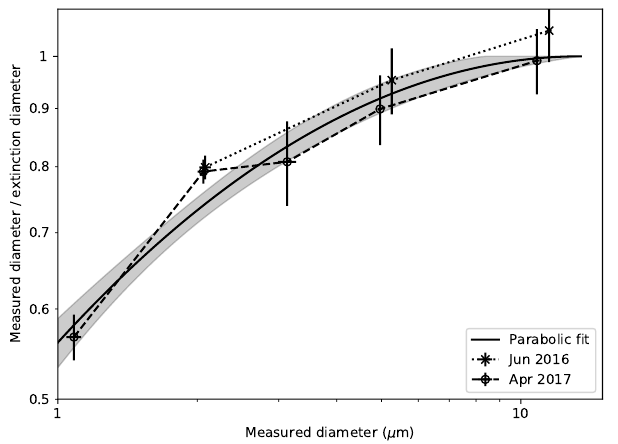
Figure 5. Size distributions of the dust particles in the RECAP ice core for both the Holocene and last glacial period measured by the Abakus and Coulter counter. (a, b) Probability density functions of the number of particles as a function of volumetric diameter, mea- sured diameter or extinction diameter for Coulter counter (black, volumetric diameter), raw Abakus (blue, measured diameter), ex- tinction calibrated Abakus (Sect. 3.2) (orange, extinction diameter), modeled Abakus data based on Coulter counter data and the aspect ratio measured by SPES (Sect. 3.4) (green, extinction diameter), and Abakus data fully calibrated to Coulter counter data using both the extinction calibration and aspect ratio (Sect. 3.5) (red, volumet- ric diameter). The uncertainty (shaded area) in the raw Abakus data is measurement uncertainty (the Supplement H), while the remain- ing uncertainties are linearly propagated from the Abakus and as- pect ratio uncertainties. (c, d) Raw Abakus data divided by Coulter counter (blue, from blue and black in a, b ), extinction calibrated Abakus data divided by modeled Abakus data (orange, from orange and green in a, b ) and fully calibrated Abakus data divided by Coul- ter counter (red, from red and black in a, b ). (e, f) Probability den- sity functions of particle volume derived from the number density functions in (a, b) for Coulter counter (black), raw Abakus (blue) and fully calibrated Abakus data